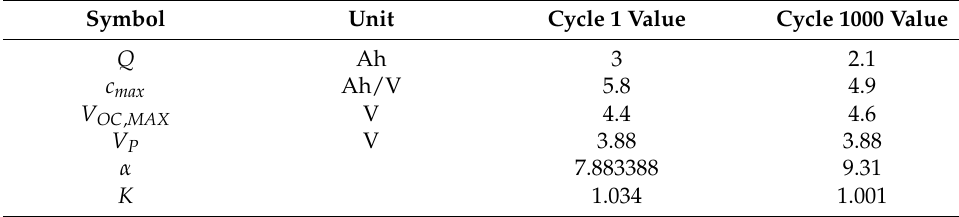
Figure 7. Model fitting of cycle tests of Type-1 battery compared to the dotted lines obtained from [19]. Table 2. Parameters for Type-1 batteries.